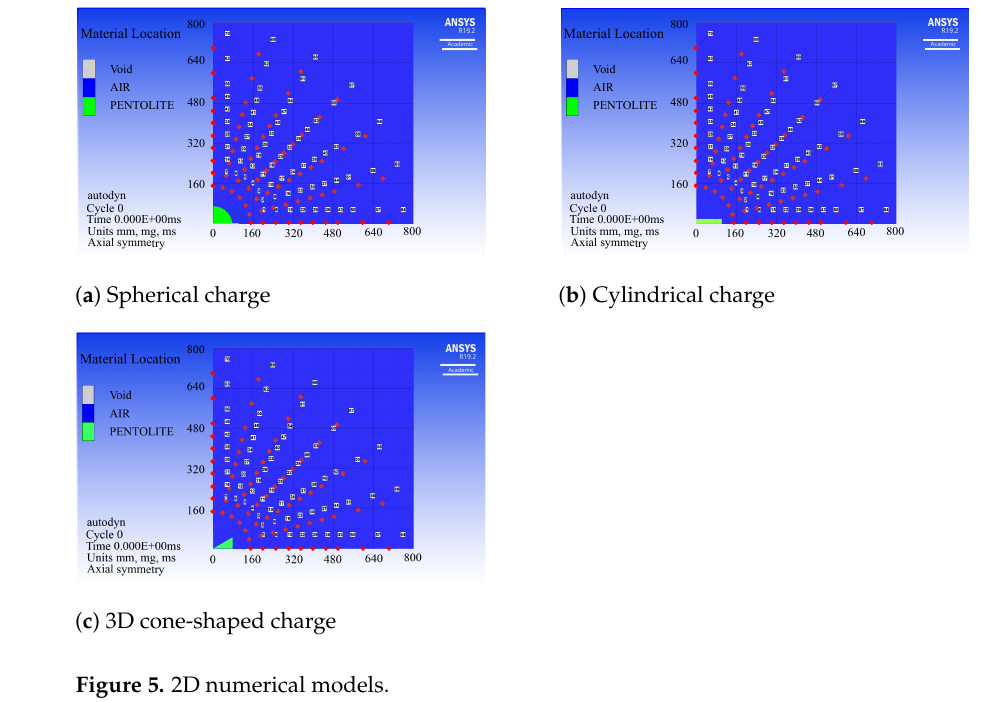
Figure 4. 2D Axially symmetric model.